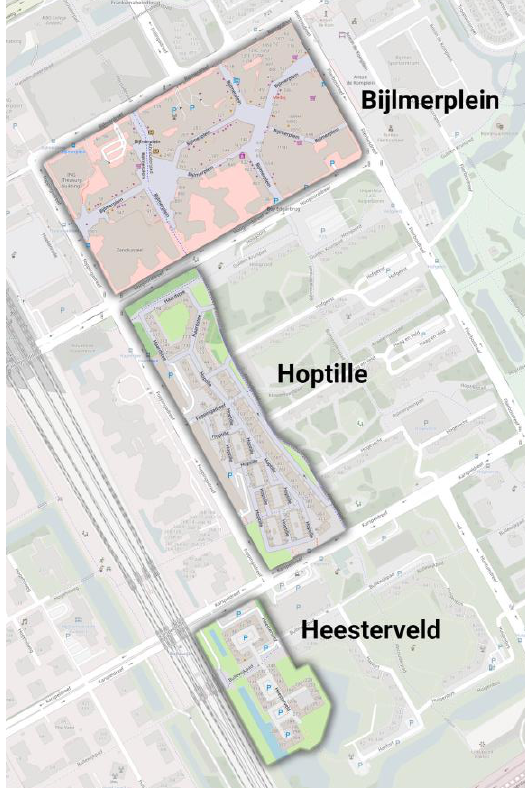
Figure 2. map of case study area in Amsterdam Zuidoost. Figure 2. Map of case study area in Amsterdam Zuidoost.